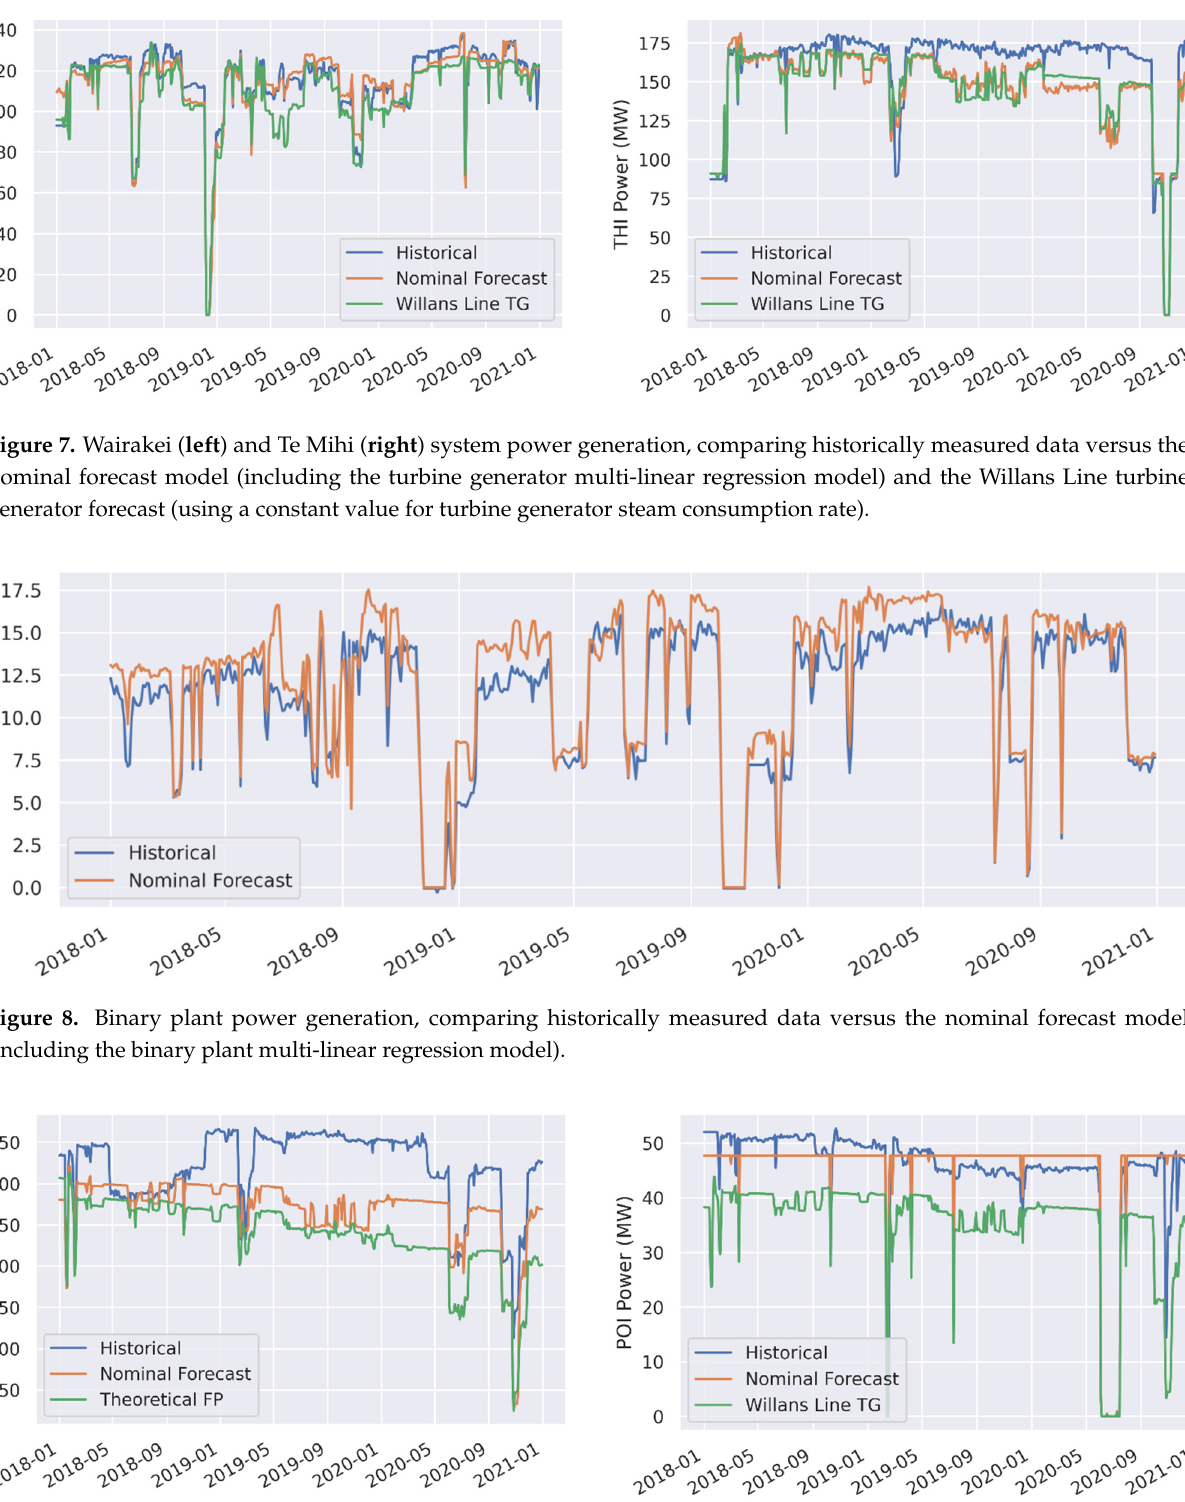
Figure 9. Poihipi Road separated steam flow ( left ) and turbine generator power ( right ), comparing the historically measured data versus the nominal forecast model and the theoretical flash plant and turbine generator models. Table 2. Comparison of results of steamfield model components in the GOOML environment based on mean bias error (MBE) and mean absolute error (MAE) between historical and forecast data. Relative error values are calculated with respect to the mean historical value.